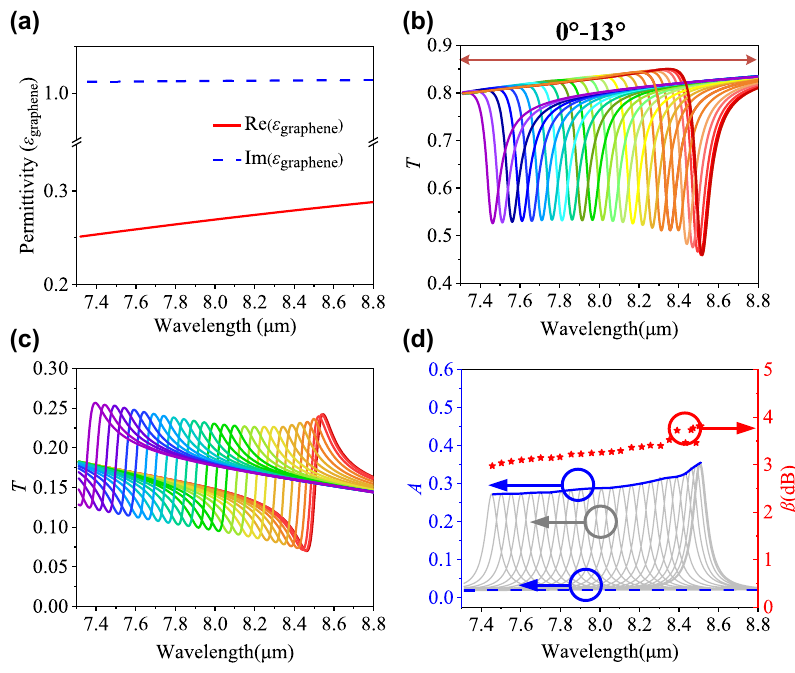
Figure 5: Permittivity of graphene and its detectionresults.(a)Realpartandimaginary part of permittivity of graphene